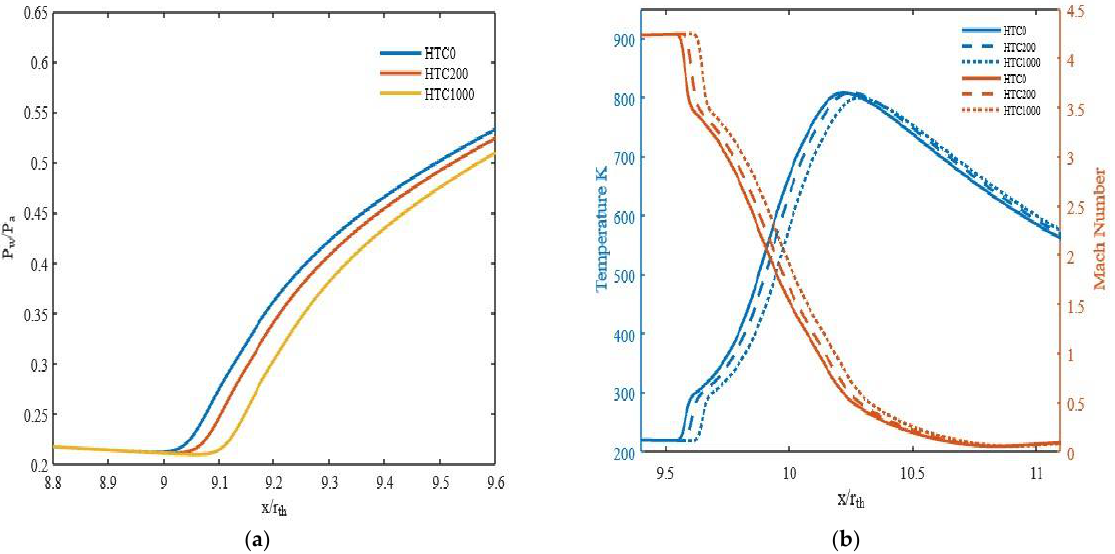
Figure 11. NPR 40 at an inlet temperature of 1000 K for different heat transfer coefficients: ( a ) Pres- sure distribution along the nozzle wall, ( b ) Temperature and Mach number variation at a distance y = 0.0015 m from the nozzle wall.